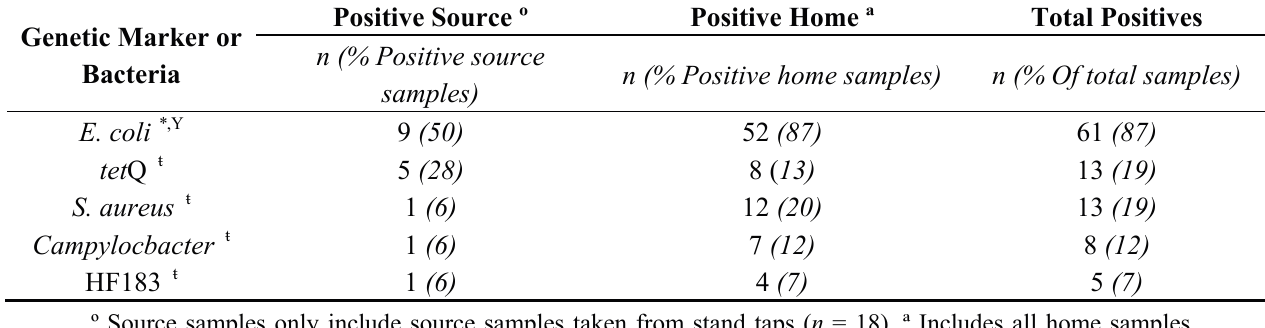
Table 4. Microbial contamination found in water samples from stand tap water sources and all home storage